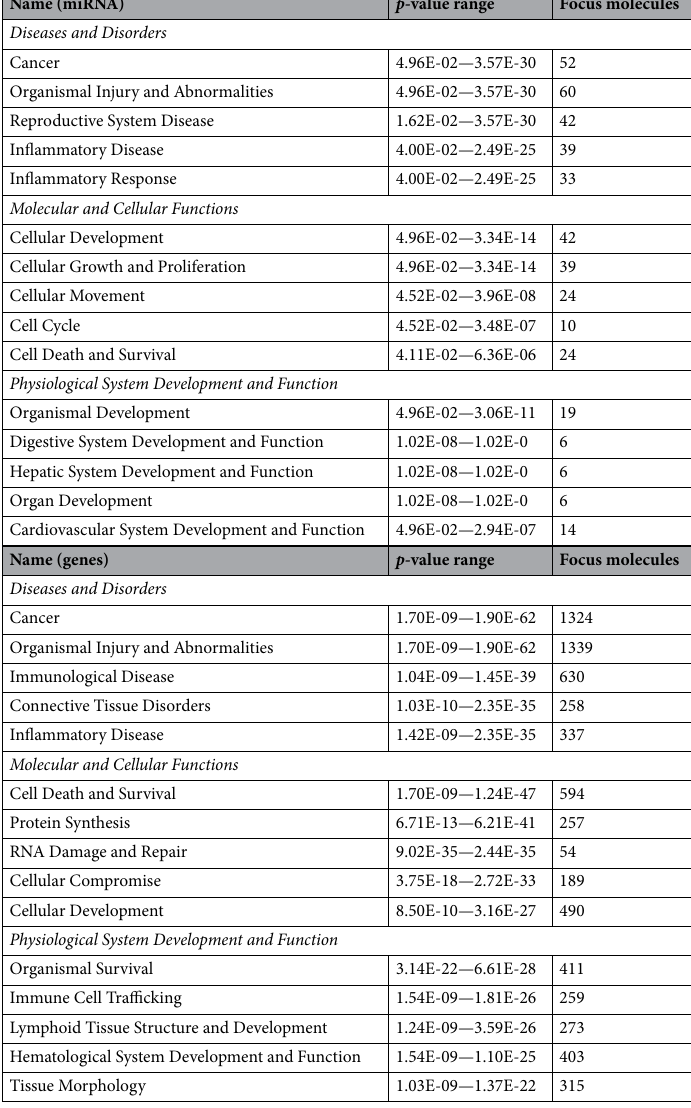
Table 2. Top five diseases and bio functions identified by IPA analysis of miRNA and mRNA in MM.